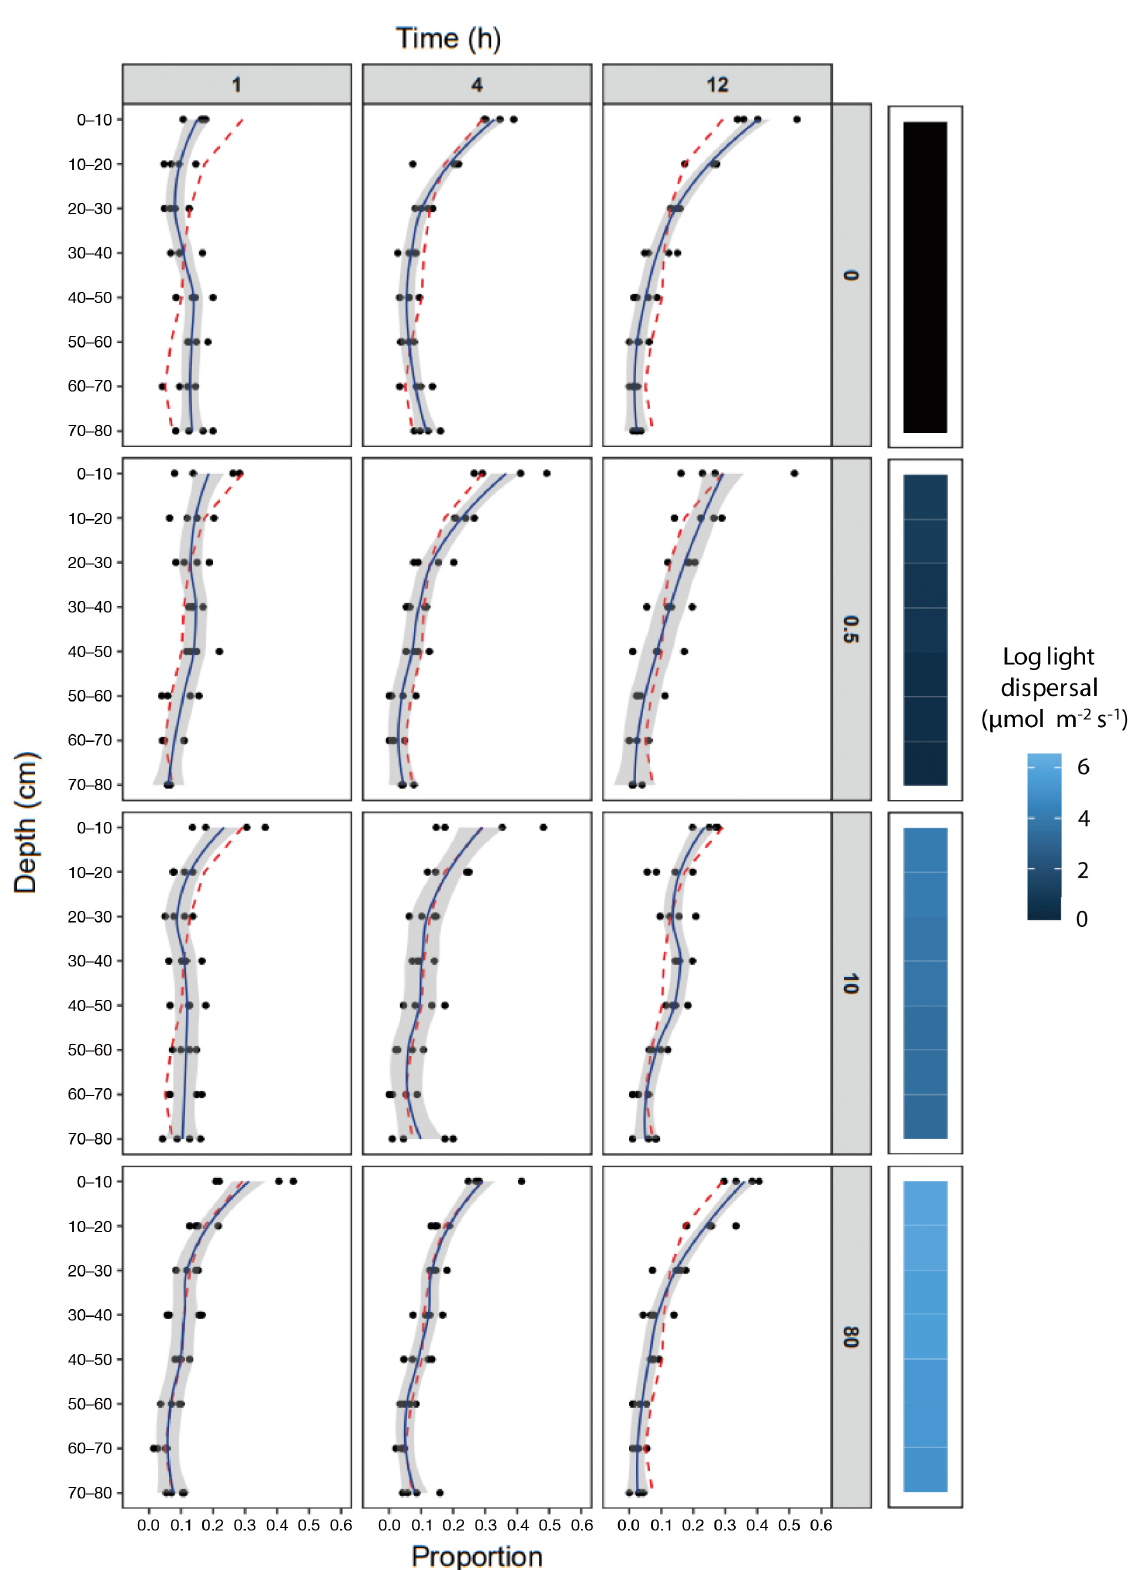
Fig. 6. Proportion of salmon lice Lepeophtheirus salmonis copepodids found in 10 cm increments in the column (0−80 cm) ex- posed to 0, 0.5, 10 or 80 μmol m −2 s −1 after 1, 4 and 12 h. Points: individual data points; lines: smoothed loess average; shading: SE. Bar graph (right) describes the average log irradiance in 10 cm increments throughout the column. Red dashed line: overall average used to compare distributions in generalised additive model